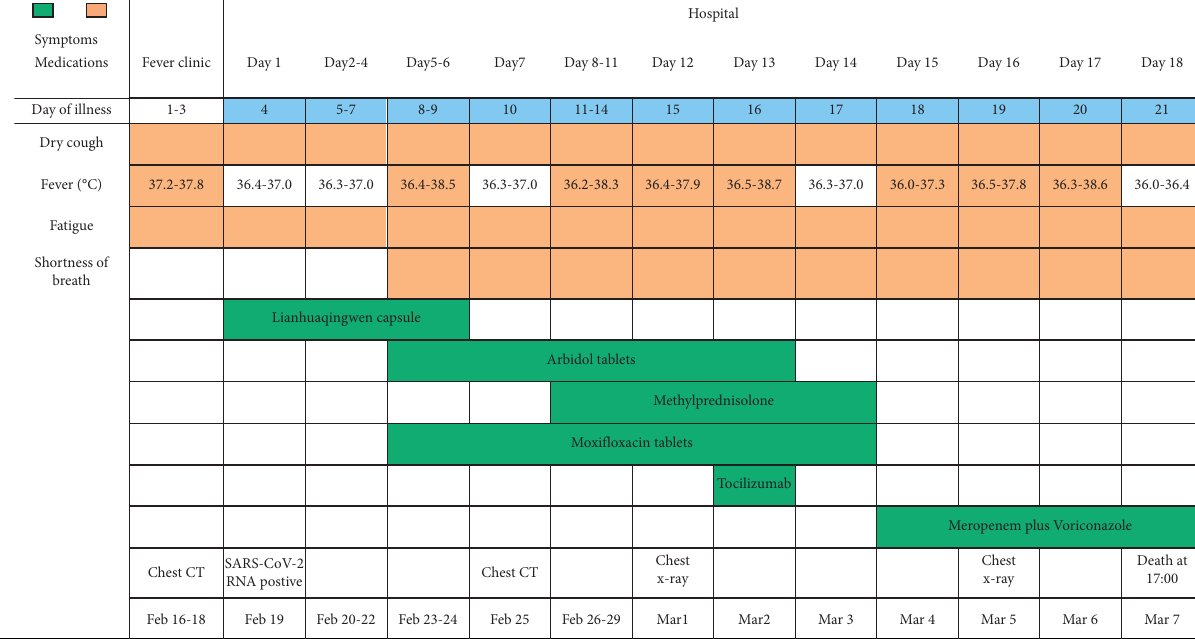
Table 5: Timeline of disease course according to days from initial presentation of illness and days from hospital admission, from February 16 to March 7, 2020. SARS-CoV-2 � severe acute respiratory syndrome coronavirus